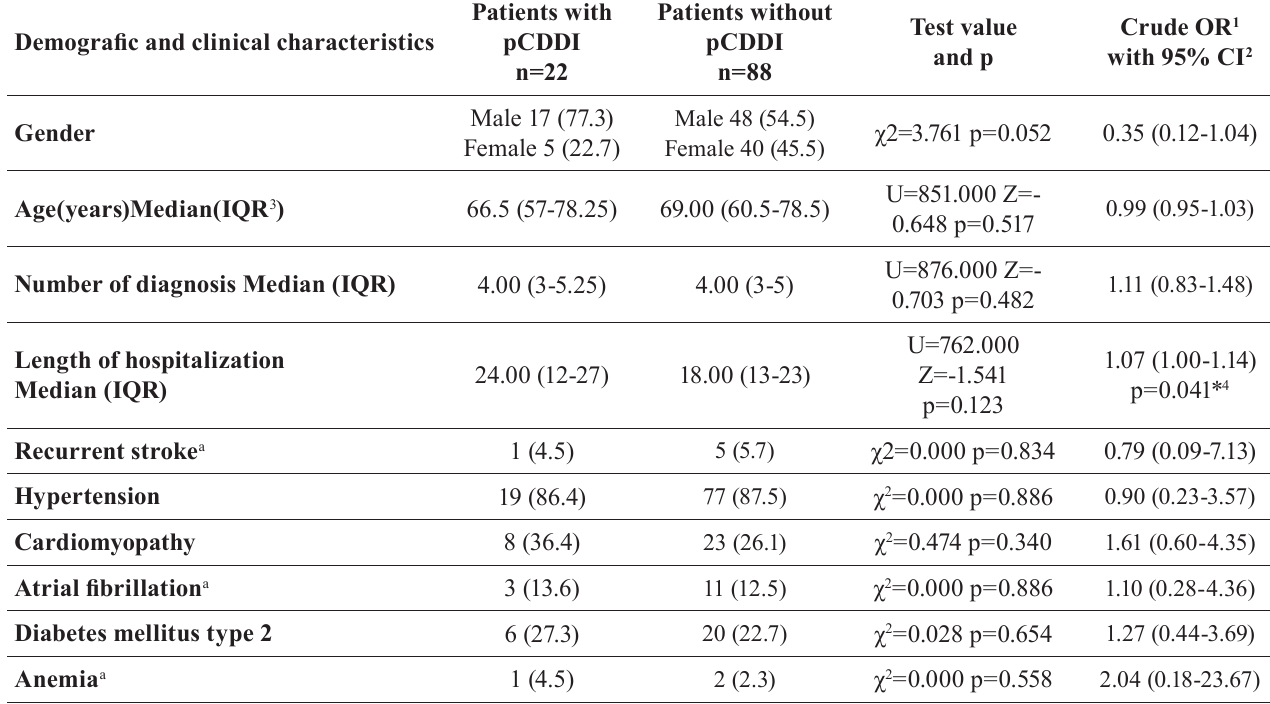
TABLE IIA - Baseline demographic and clinical characteristics of two compared groups of patients Demografic and clinical characteristics